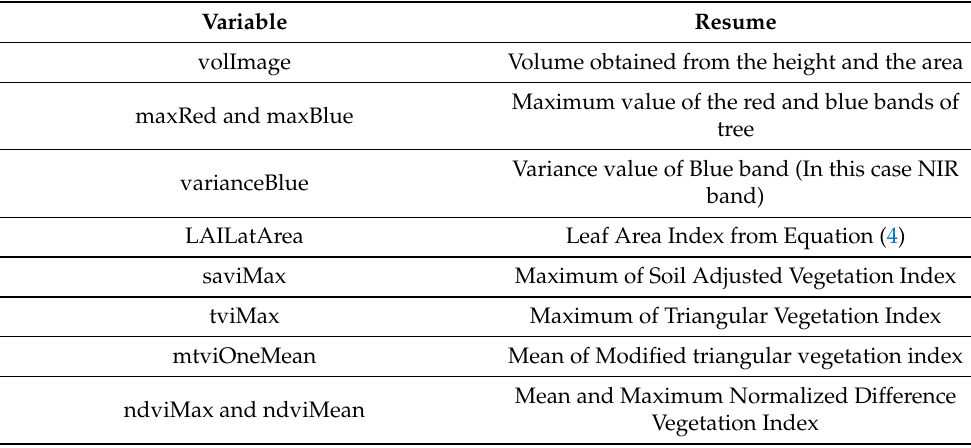
Table 2. Variables for the multiple regression process. Variable Resume volImage Volume obtained from the height and the